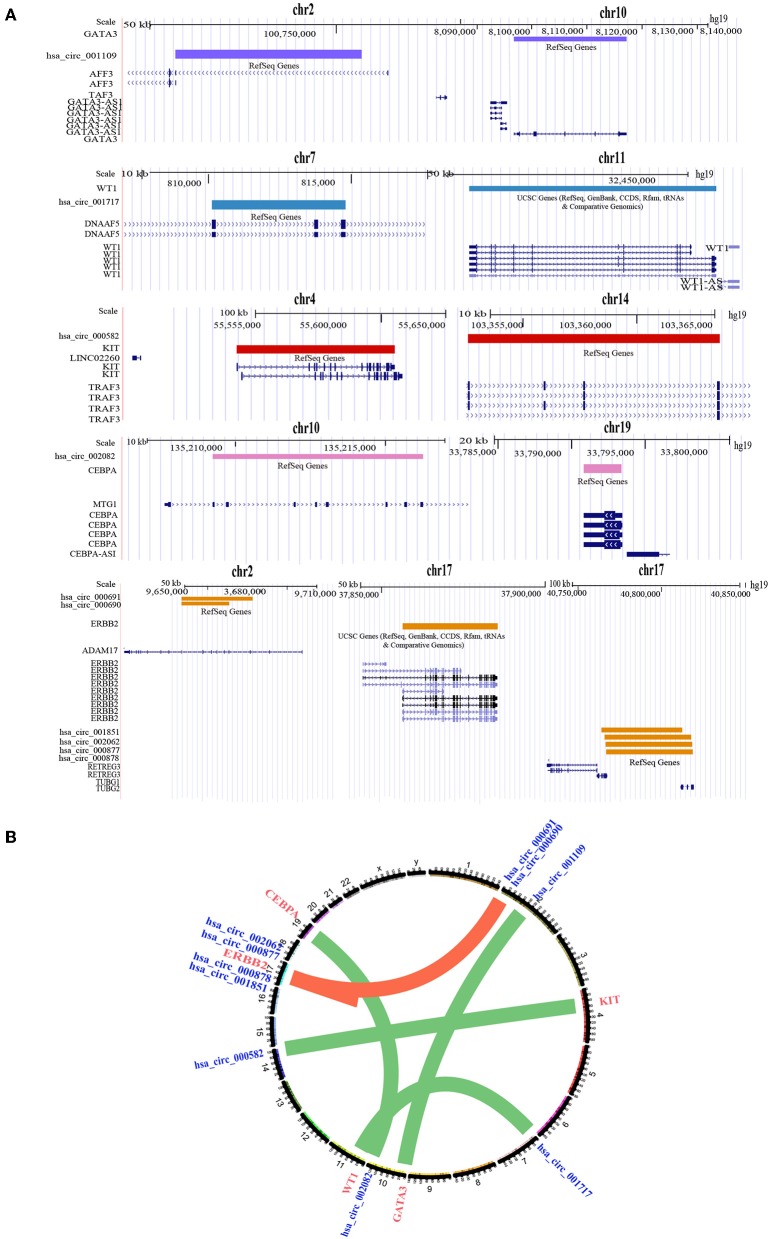
Location information of sponge circRNA-driver gene pairs. (A) Genome position information of 10 sponge circRNA-driver gene pairs. Purple bar represents the genome location of GATA3 and its sponge circRNA. Blue bar represents the genome location of WT1 and its sponge circRNA. Red bar represents the genome location of KIT and its sponge circRNA. Pink bar represents the genome location of CEBPA and its sponge circRNA. Yellow bar represents the genome location of ERBB2 and its sponge circRNAs. (B) Sponge circRNA-driver gene pairs in breast cancer. The nodes represent circRNAs and driver genes (blue represents circRNAs, red represents driver genes) and the edges represent the predicted regulation between sponge circRNA and the corresponding protein-coding driver gene.